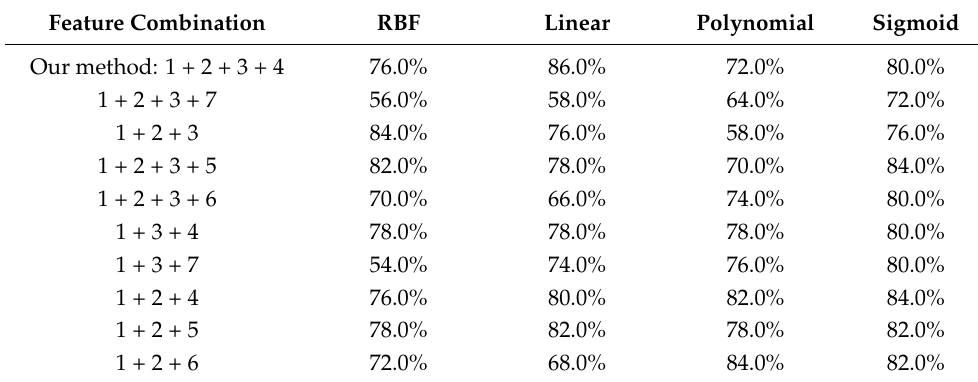
Table 17. The accuracy of G-SVR with different kernel